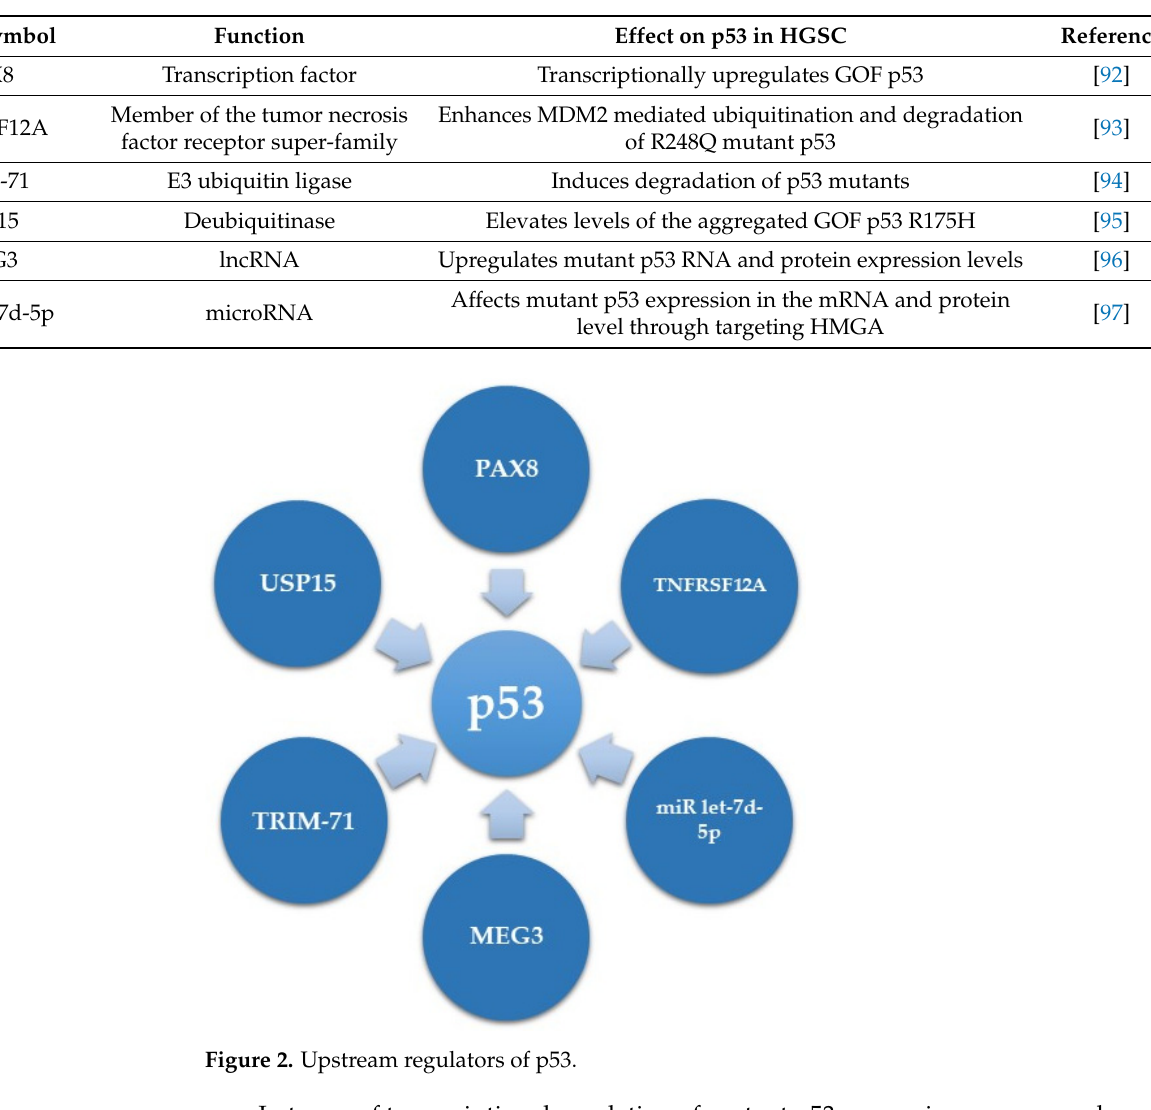
Table 1. Regulators of mutant p53 function.